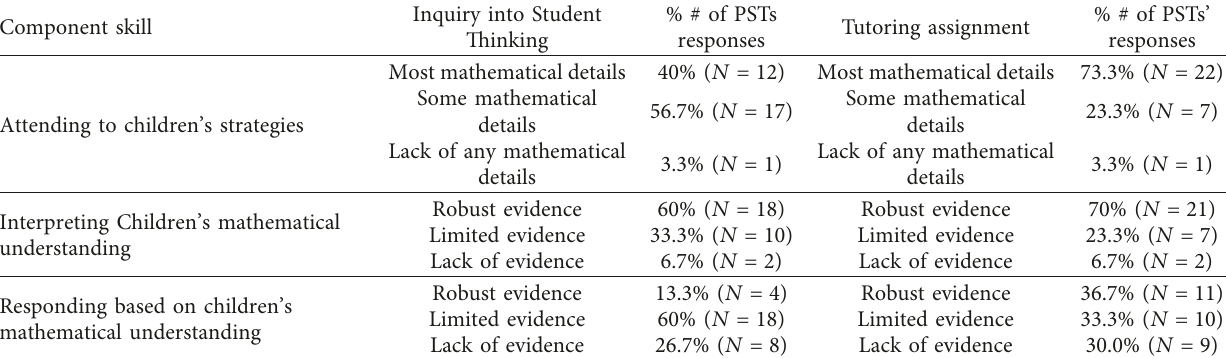
Table 6: Summary of PSTs’ responses in the two